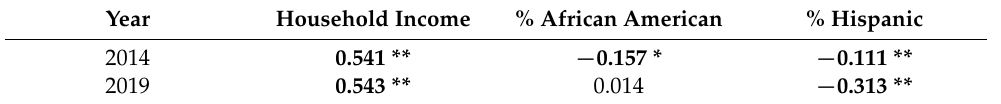
Table 6. Bivariate correlations between % EUTC and socioeconomic variables.